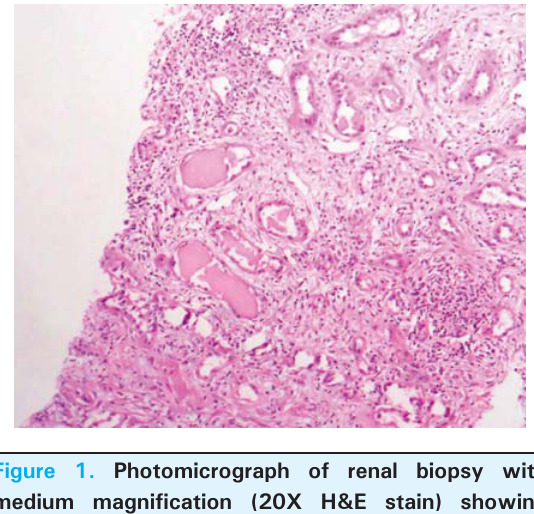
Figure 1. Photomicrograph of renal biopsy with medium magni fi cation (20X H&E stain) showing intratubular myeloma casts with a fractured appearance with accompanying epithelial cell reaction, tubular injury and chronic tubulointerstitial